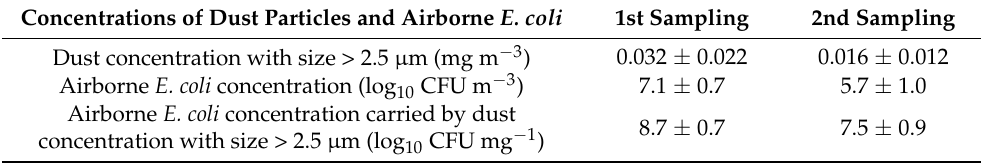
Table 3. Concentrations (Mean ± SD) of dust particles with size larger than 2.5 µ m, airborne E. coli and airborne E. coli -to-dust ratio during air sampling for survivability test of airborne E. coli . The 2nd sampling was performed 20 min after 1st sampling. Concentrations of Dust Particles and Airborne E.